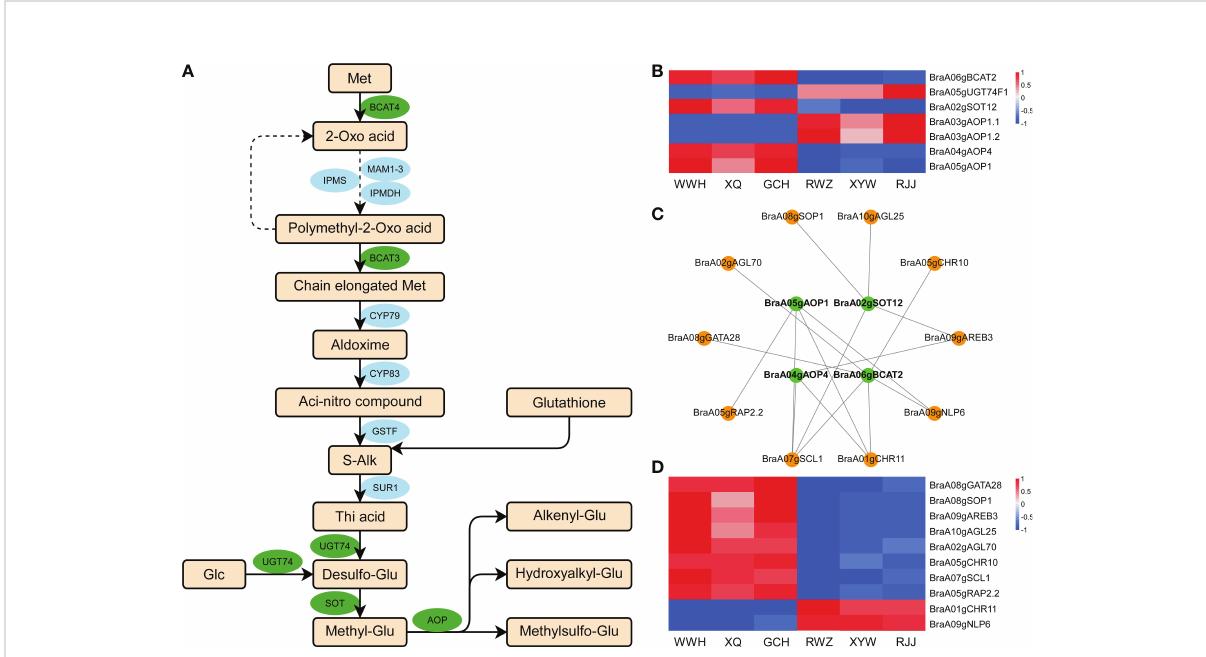
FIGURE 5 Aliphatic glucosinolate biosynthesis in Chinese cabbage. (A) Reconstruction of the aliphatic glucosinolate biosynthetic pathway with the differentially expressed structural genes. Green ellipses represent essential genes we identi fi ed by RNA-Seq; blue ellipses represent the genes involved in the glucosinolate biosynthesis. (B) Heatmap of the DEGs involved in aliphatic glucosinolate biosynthesis. (C) Correlation network of crucial genes involved in aliphatic glucosinolate biosynthesis in yellow and white inner-leaf Chinese cabbage. Green circles represent structural genes; orange circles represent TFs. (D) The expression of transcription factors involved in glucosinolate biosynthesis in RNA-Seq